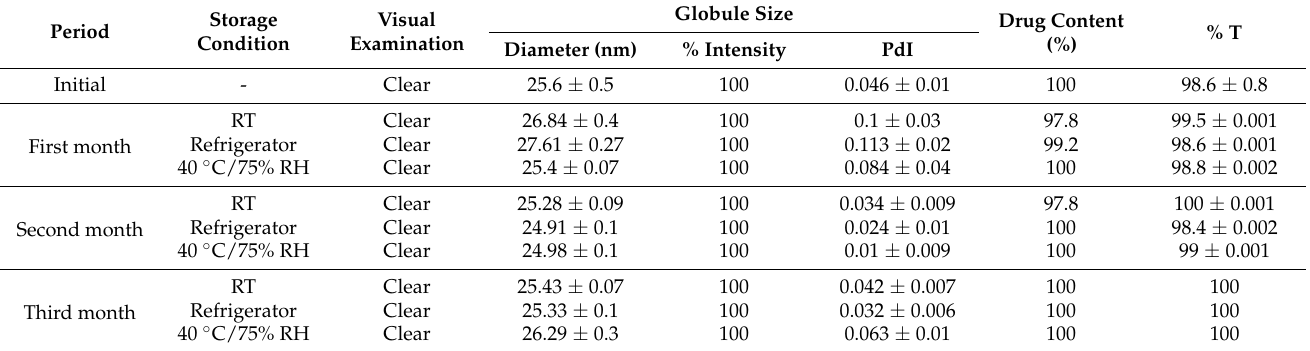
Table 10. Results of long-term stability study of P2 TD NE formulation at different storage